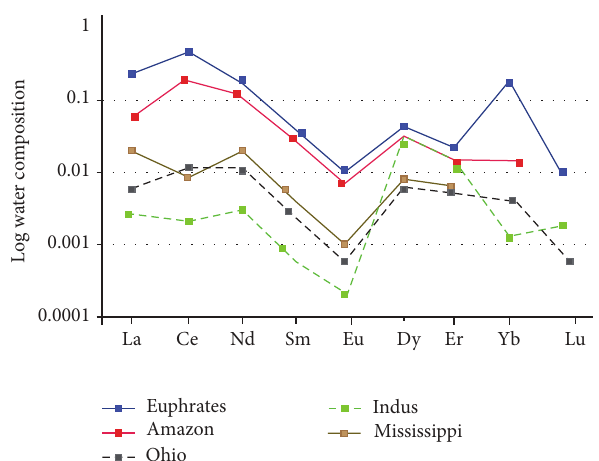
Figure 6: Distribution of REE in the Euphrates River waters and the Amazon, Indus, Mississippi, and Ohio River waters data from Goldstein and Jacobsen